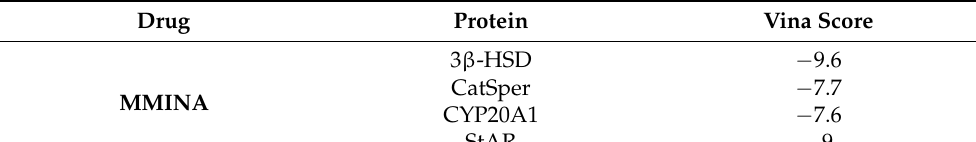
Table 4. MMINA and 3 β -HSD, CatSper, CYP20A1, and StAR docked complexes along with the vina score.